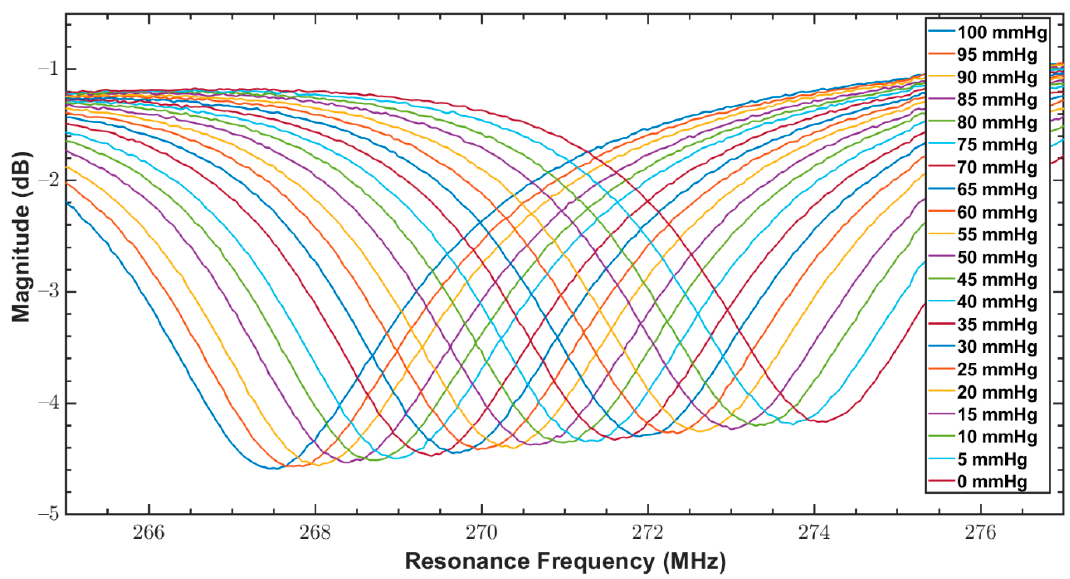
Figure 12. Reflection coefficients (S11 parameter) of S2 for a pressure range of 0 to 100 mmHg.